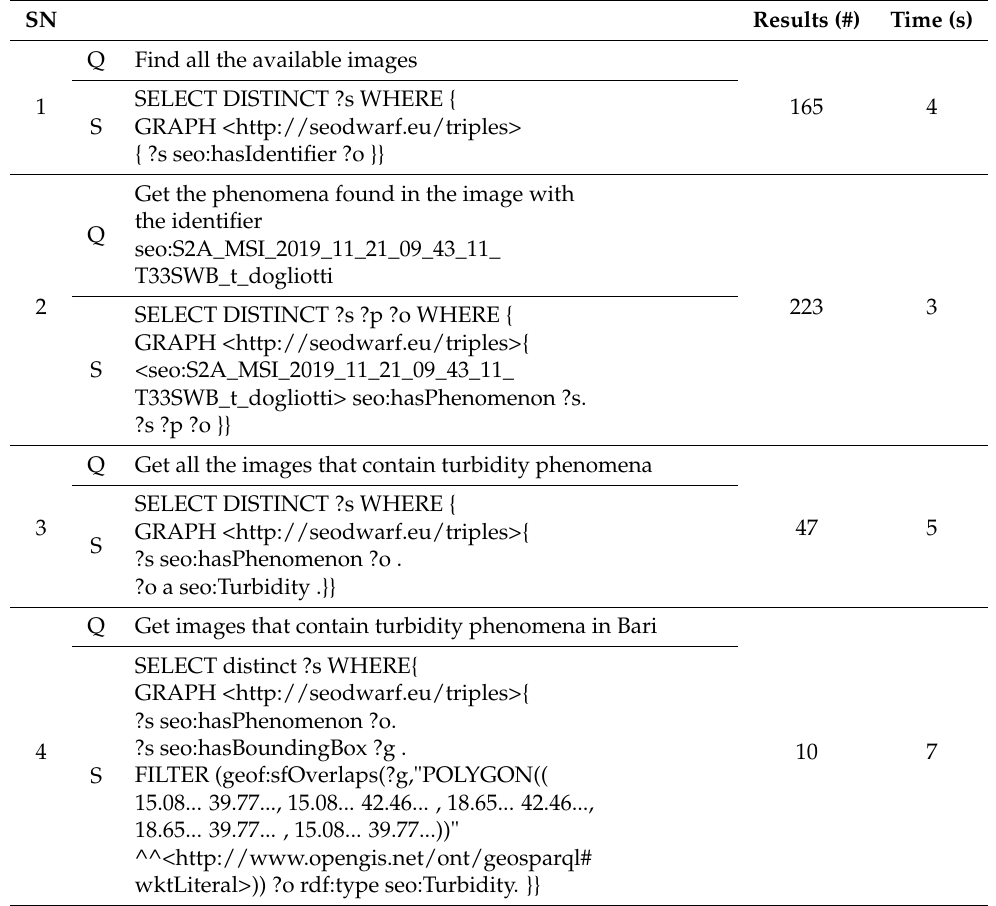
Table 6. Results for the example